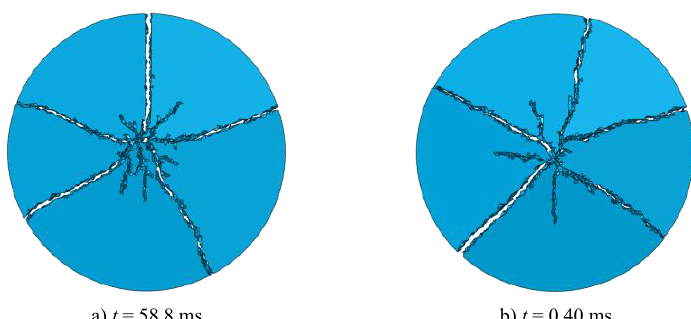
Fig. 11 Glass fragmentation (bottom view) for ring-on-ring test simulation with the *Brittle Cracking model for target piston velocities of a) 10 mm/s, and b) 1000 mm/s.